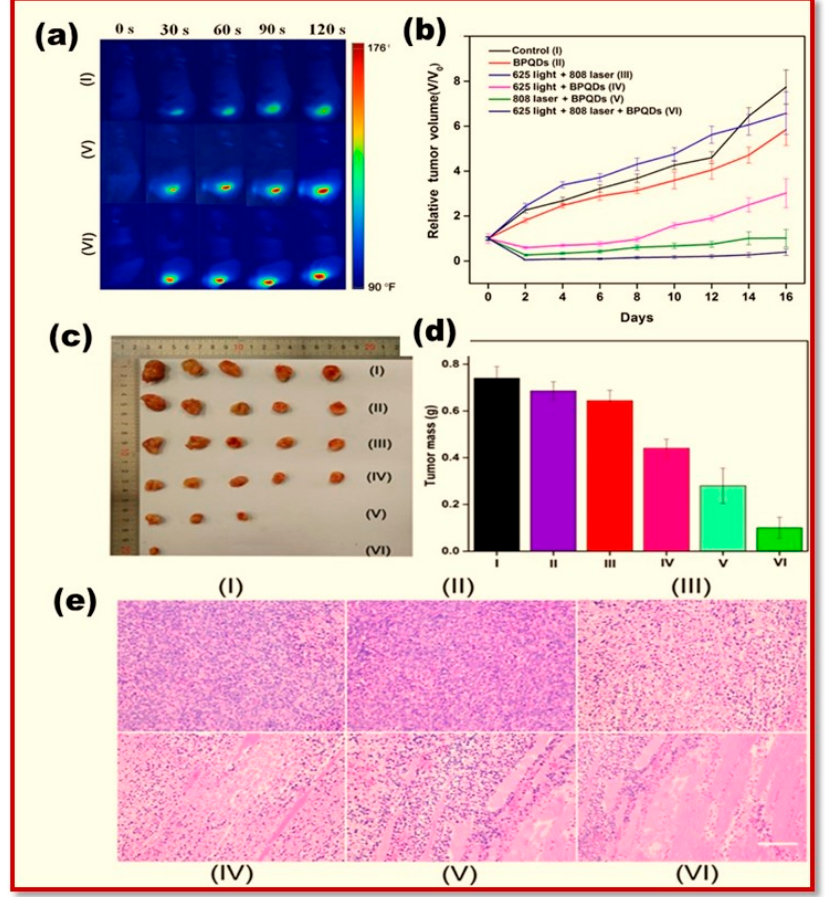
Figure 25. ( a ) Infrared thermal images of 4T1 tumor-bearing mice after 808 nm laser irradiation. ( b ) Tumor growth curves in different groups subjected with different treatments. Data are presented as mean ± SD. ( c ) Photographs of tumors collected from different groups of mice at the end of treatments (16 day). ( d ) Average weights of tumors collected from different groups of mice. ( e ) Repre- sentative micrographs of H&E-stained tumor tissue slices obtained from different groups of mice. (d) group I, control; group II, BPQDs; group III, 625 nm light + 808 nm laser; group IV, 625 nm light + BPQDs; group V, 808 nm laser + BPQDs; group VI, 625 nm light + 808 nm laser + BPQDs. scale bar, 200 µm). Reprinted (adapted) with permission from ACS Appl. Mater. Interfaces [141]. Copyright 2017 American Chemical Society.